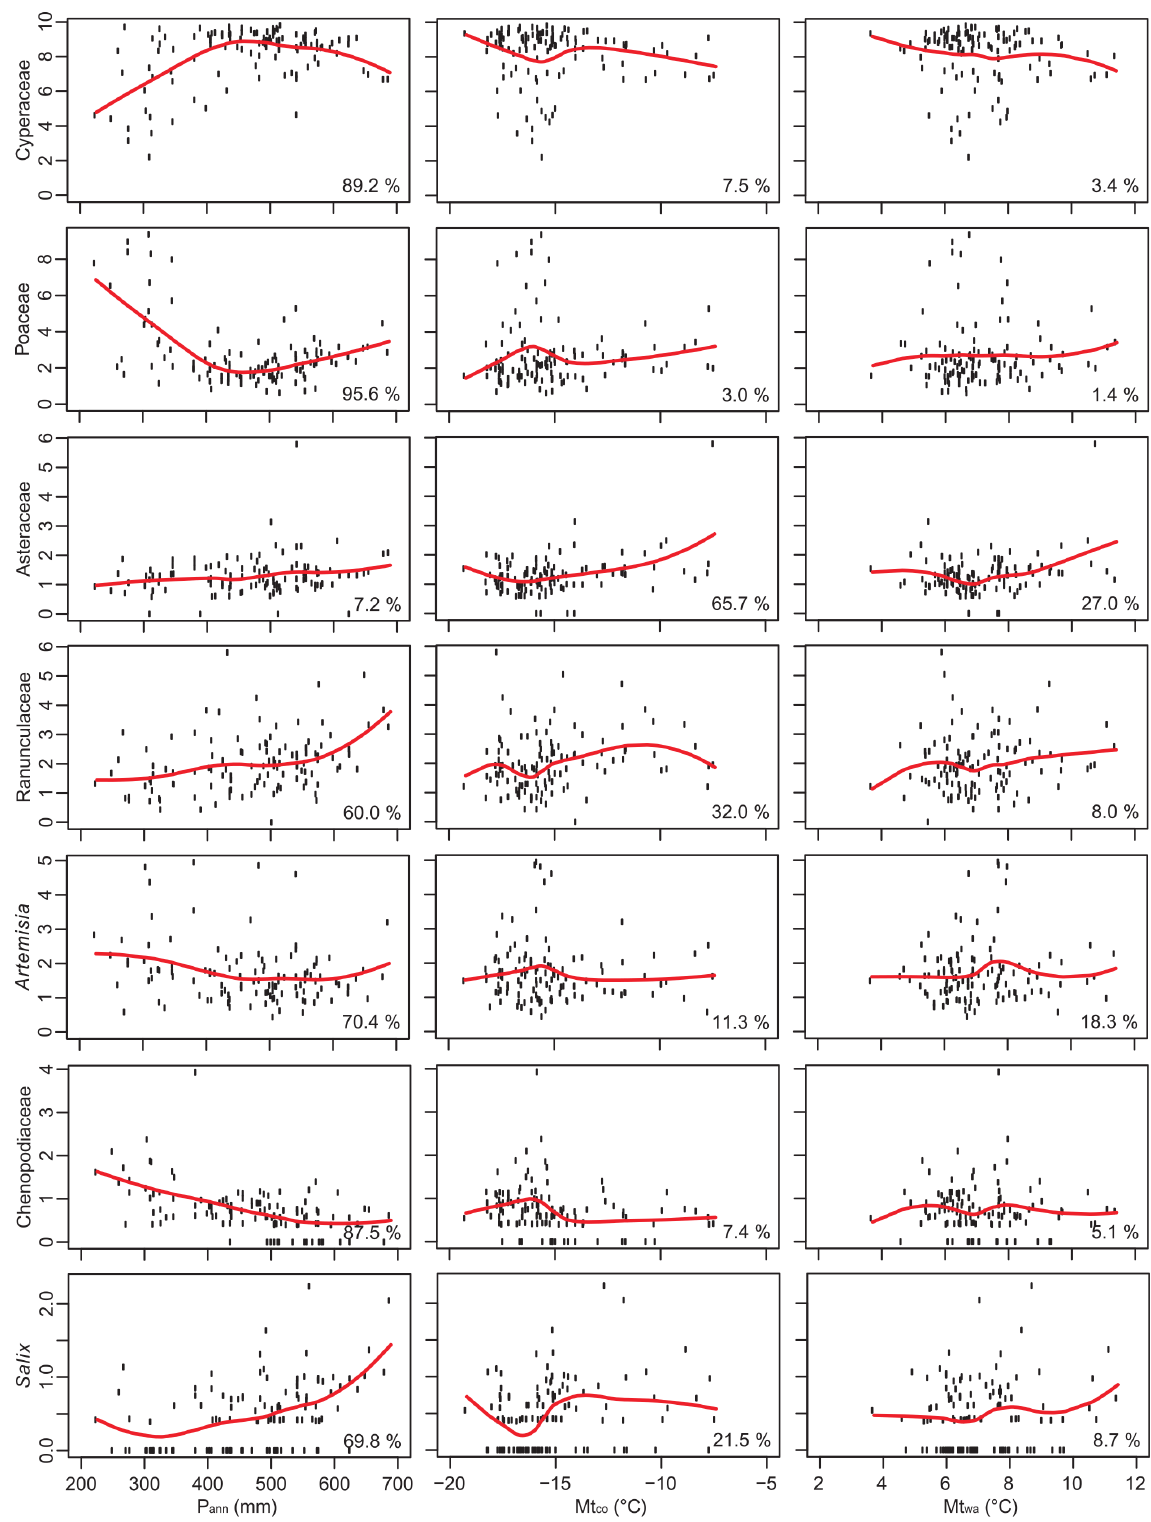
Figure 4. BRT-modelled climate influences on pollen (seven dominant or major taxa) percentages. The pollen responses to three climatic variables (red curves) are fitted with local polynomial regression